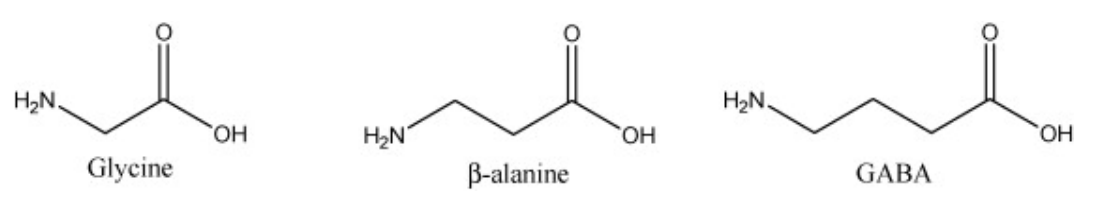
Figure 1. The structural similarities of glycine, β-alanine and GABA.